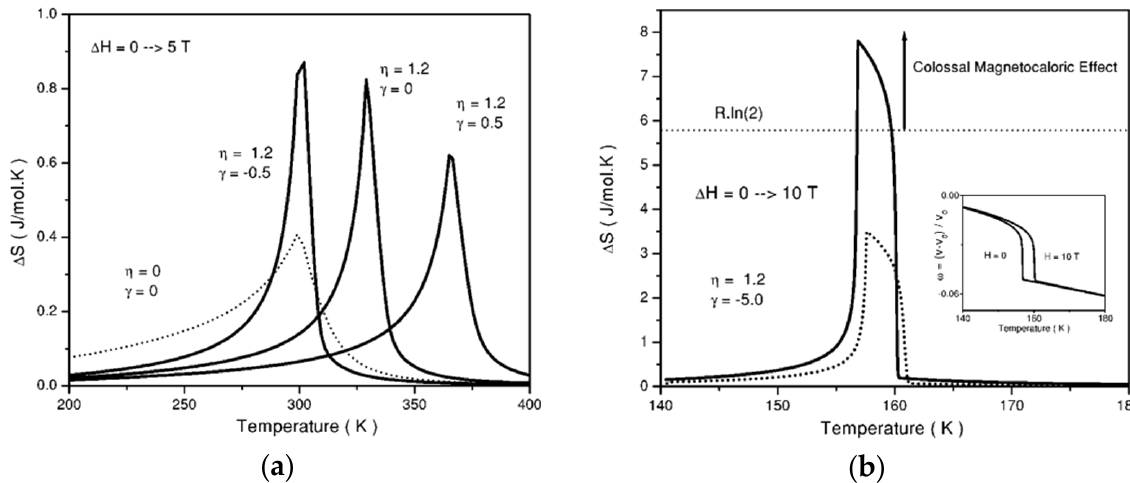
Figure 3. Total entropy variation with temperature: ( a ) For several model parameters sets chosen by the authors and for a magnetic field variation from 0 T to 5 T; ( b ) For the set 5 of the model parameters, variation of the magnetic field from 0 T to 10 T [35].